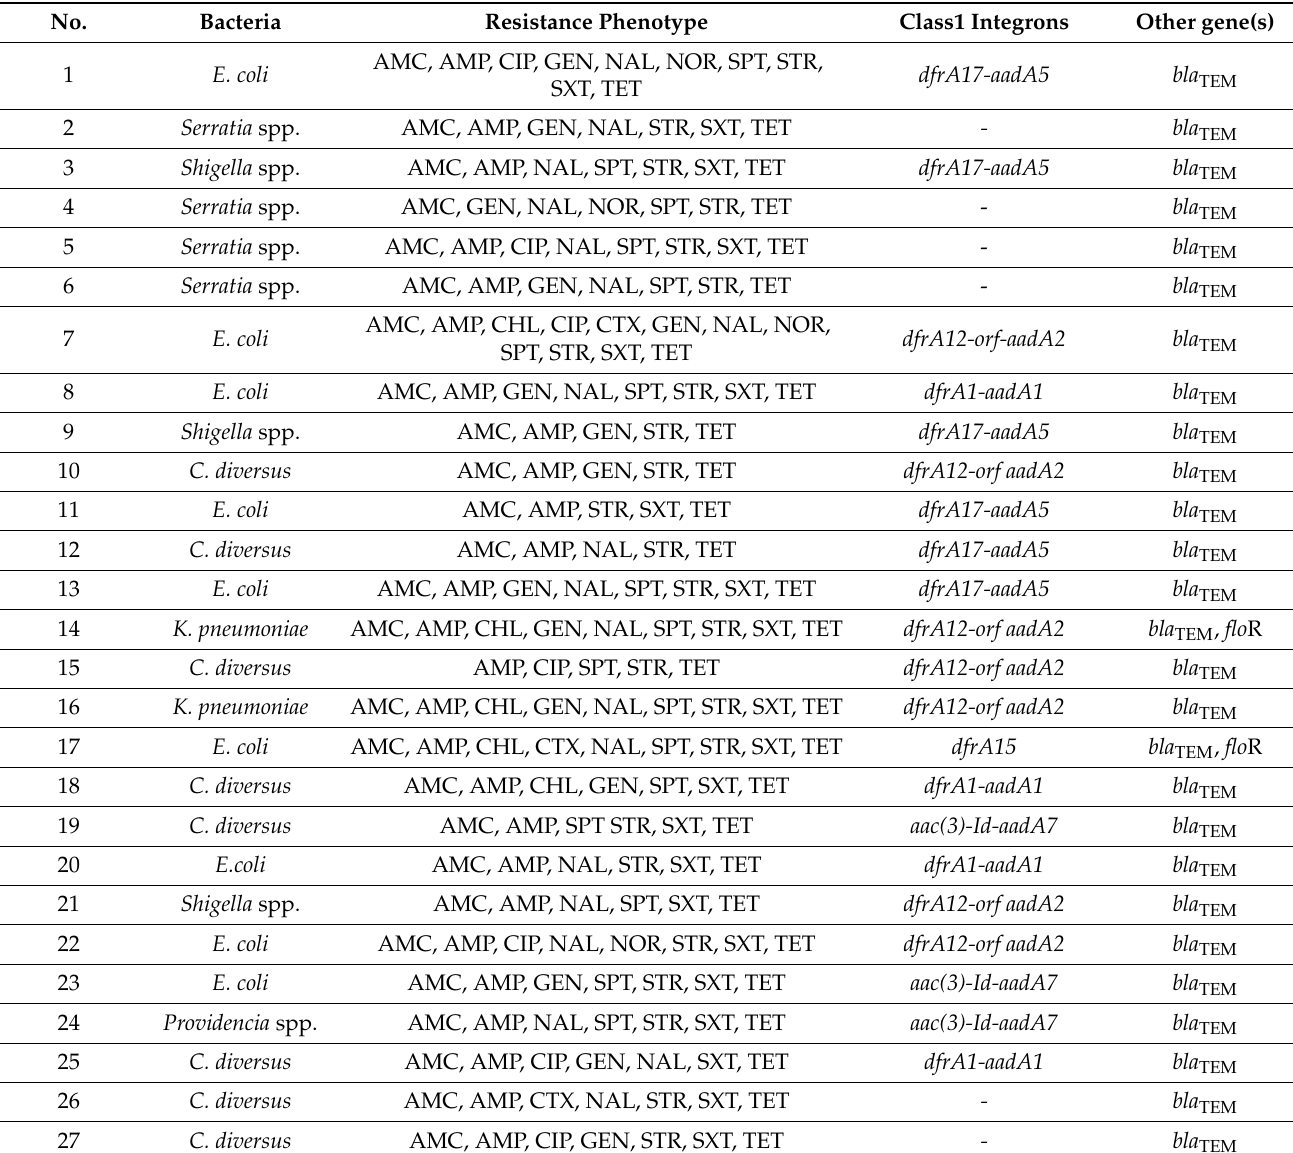
Table 5. Incidence of antimicrobial-resistant genes in multidrug resistant bacteria isolated from diarrhoeic calves.